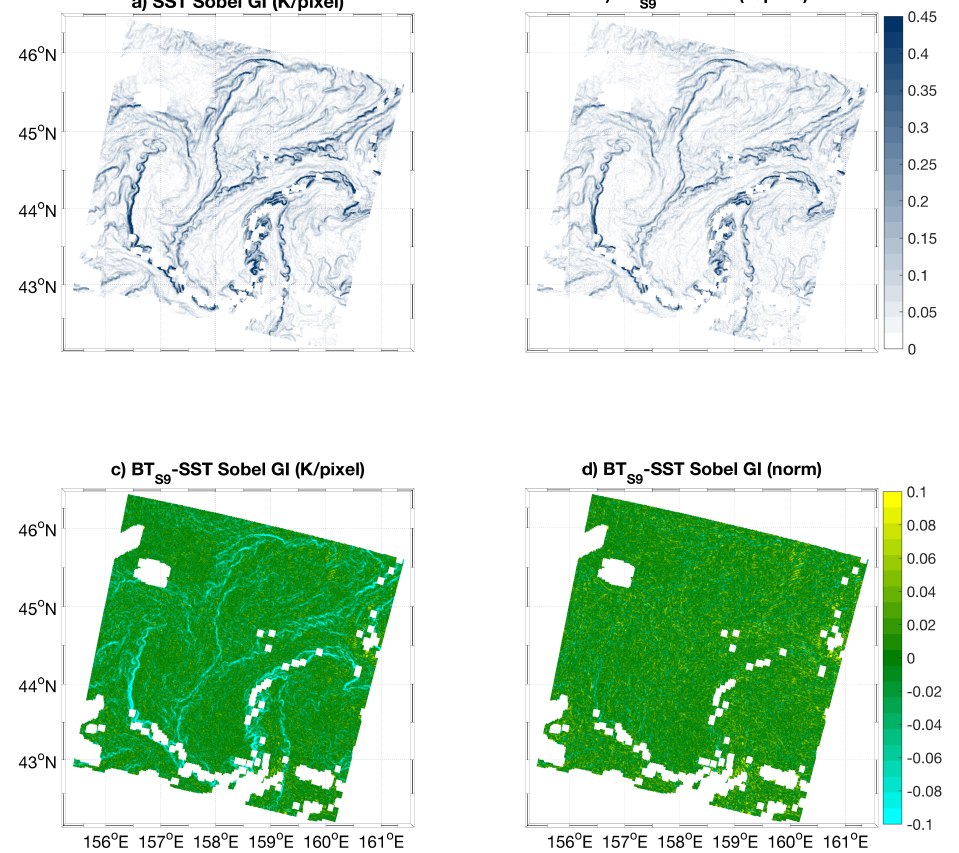
Figure 3. Maps of ( a ) SST gradient intensity (GI), ( b ) S9 channel-derived BT (BT S 9 ) GI, ( c ) difference between BT S 9 and SST GIs, ( d ) difference between the normalized BTS9 and SST GIs. In panels ( a , b ), the colorscale is limited to 0.45 K/pixel with the aim of visually emphasizing the gradient